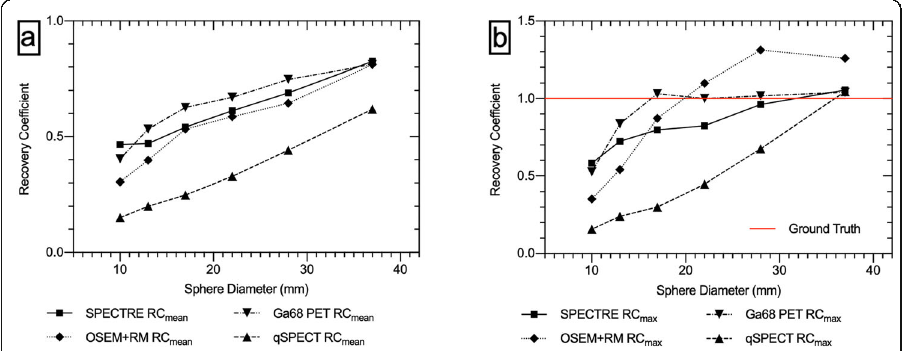
Fig. 2 a Recovery coefficient of the mean concentration in each sphere. b Recovery coefficient of the max value in each